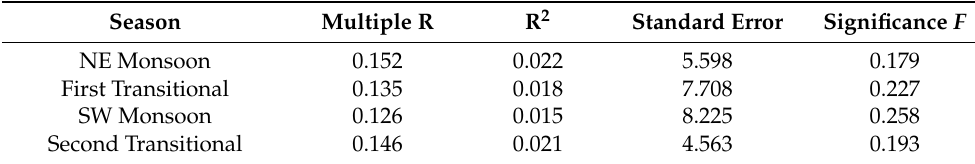
Table 3. Regression analysis of inter-seasonal SLA vs. RMM1